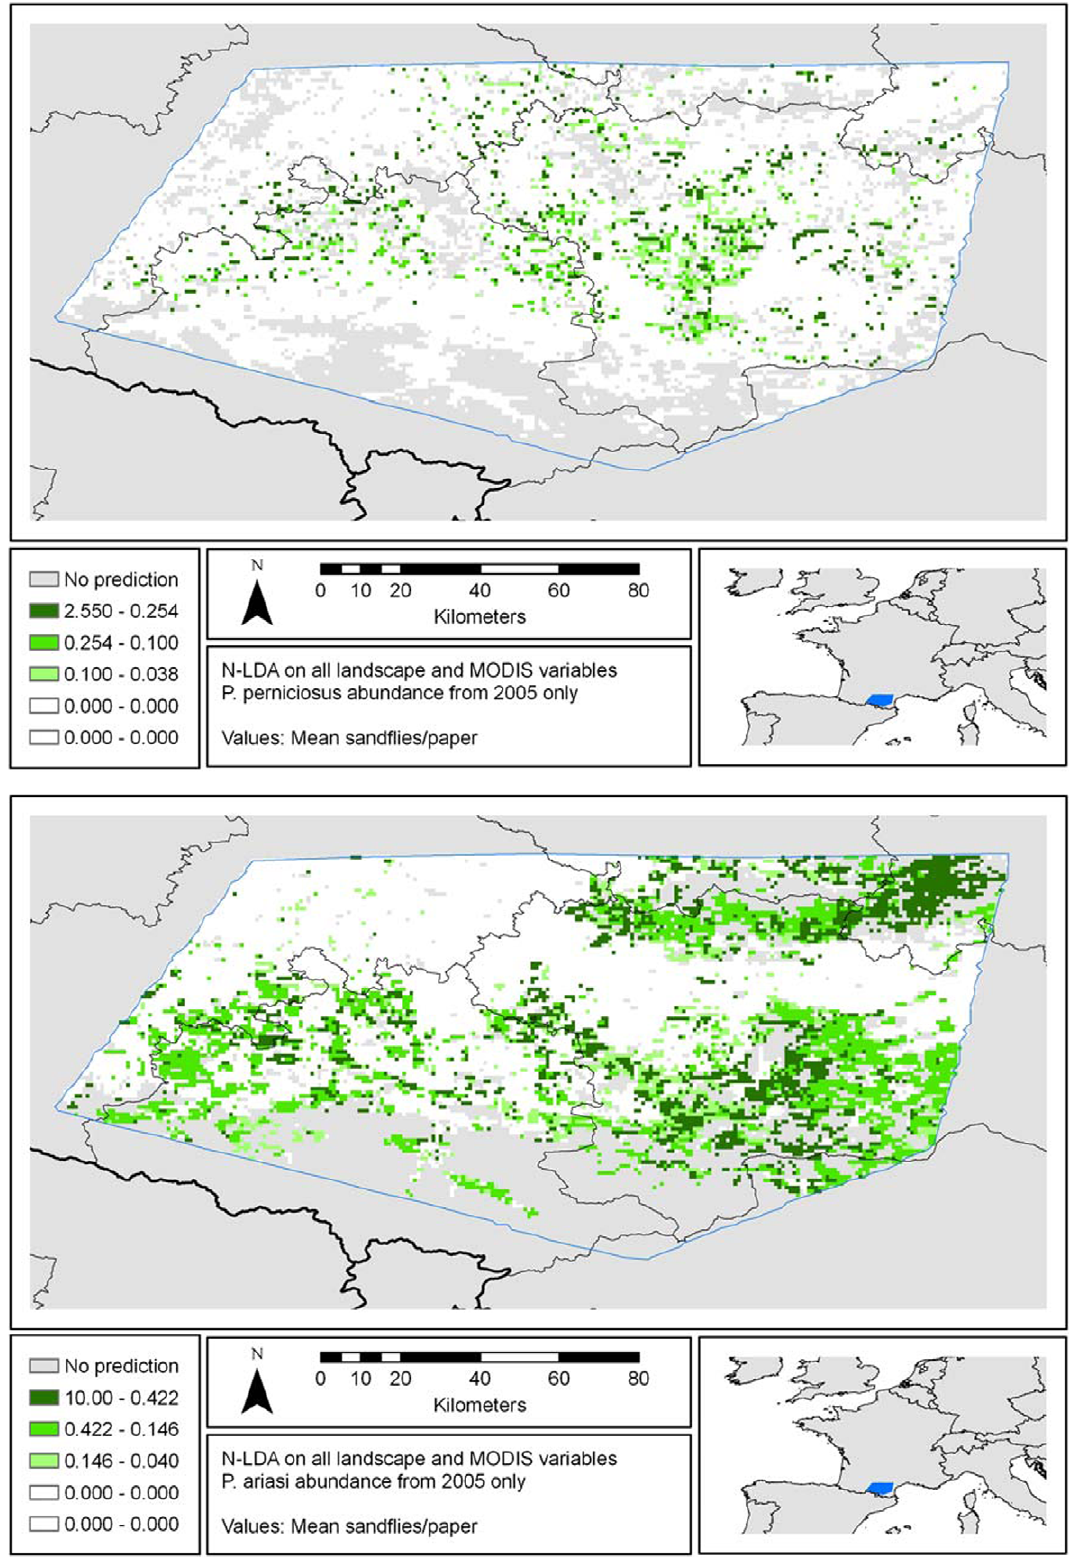
Figure 4. Predicted.abundance of P.perniciosus (upper panel) and of P.ariasi (lower panel), based on the integrated model.